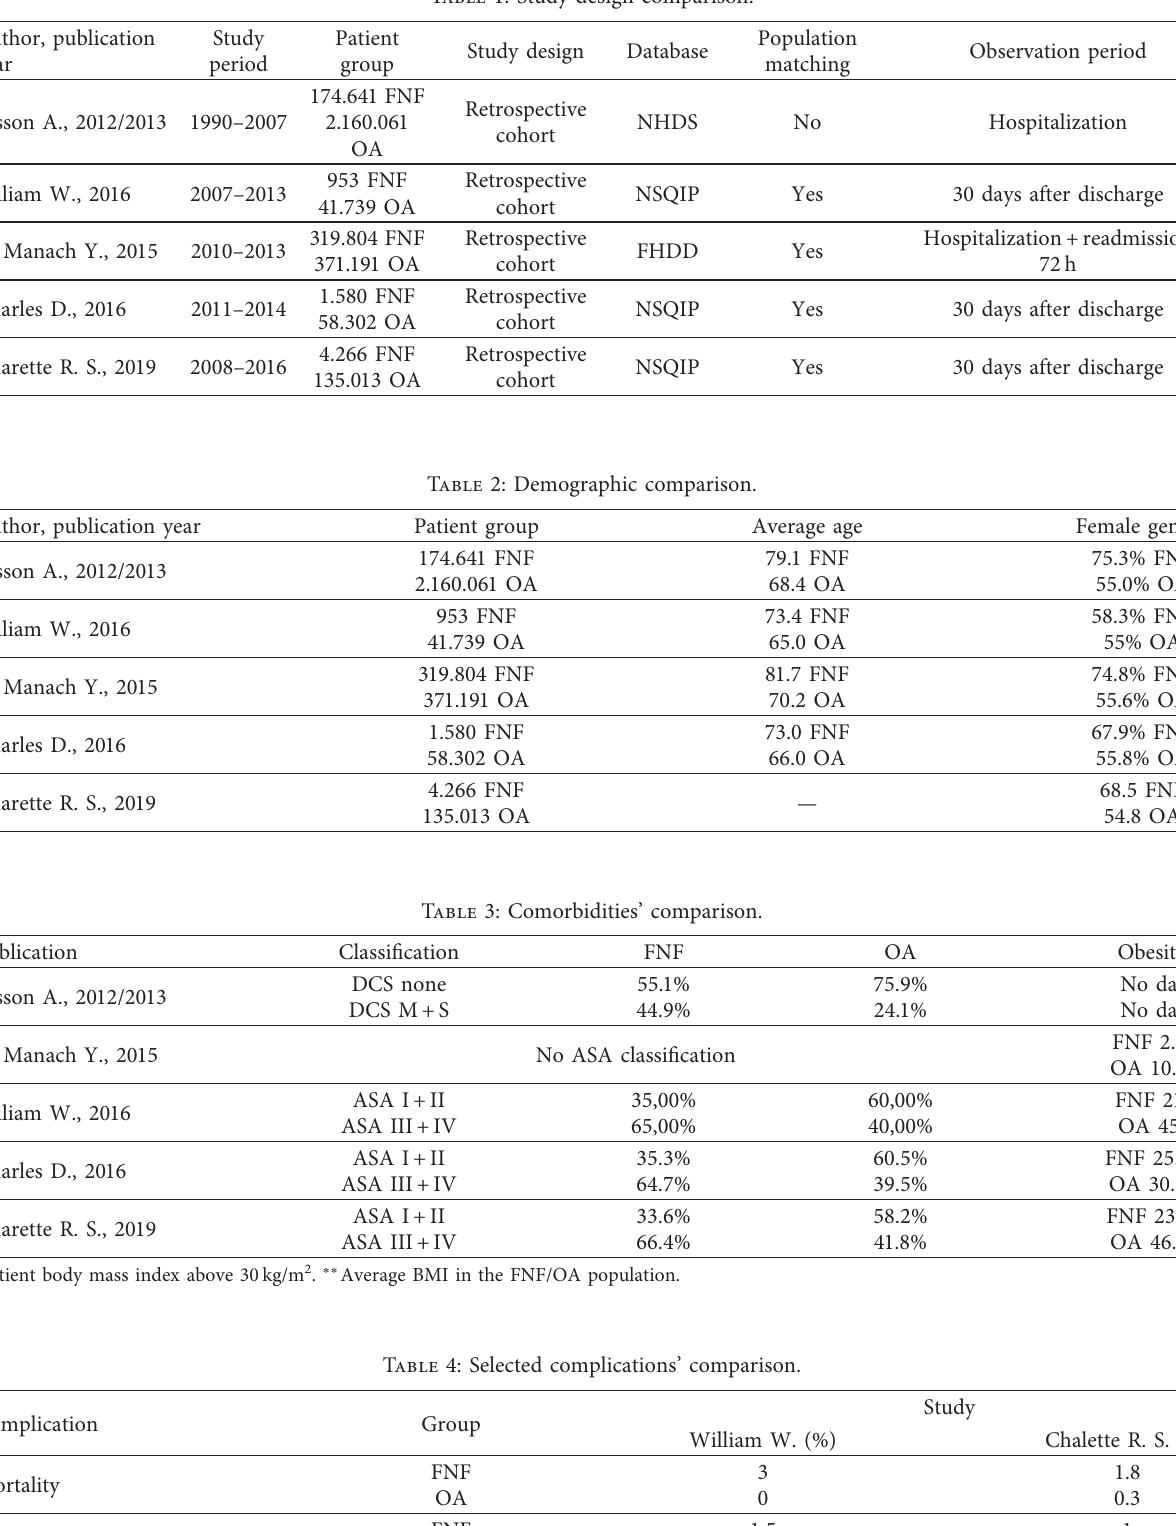
Table 1: Study design comparison.